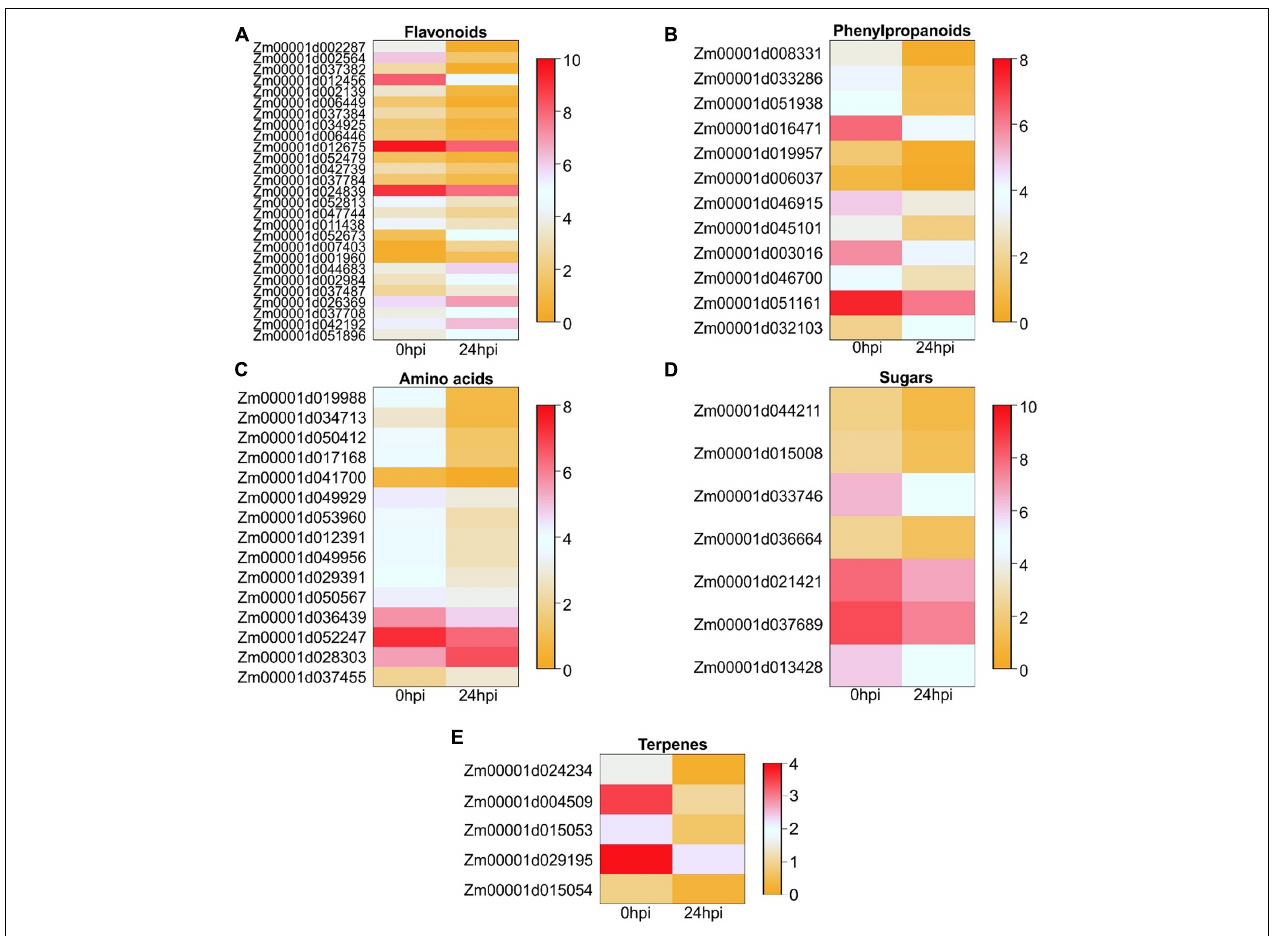
FIGURE 5 | Heatmap of the expression ECB feeding-induced genes involved in different pathways: (A) Flavonoids, (B) Phenylpropanoids, (C) Amino acids, (D) Sugars, and (E) Terpenes. For the columns Mp708_0 hpi and Mp708_24 hpi, each cell contains the relative expression level [log 2 (FPKM +